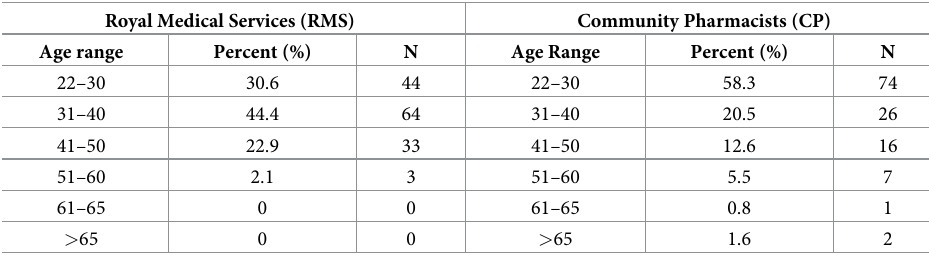
Table 1. Age distribution for RMS and CP